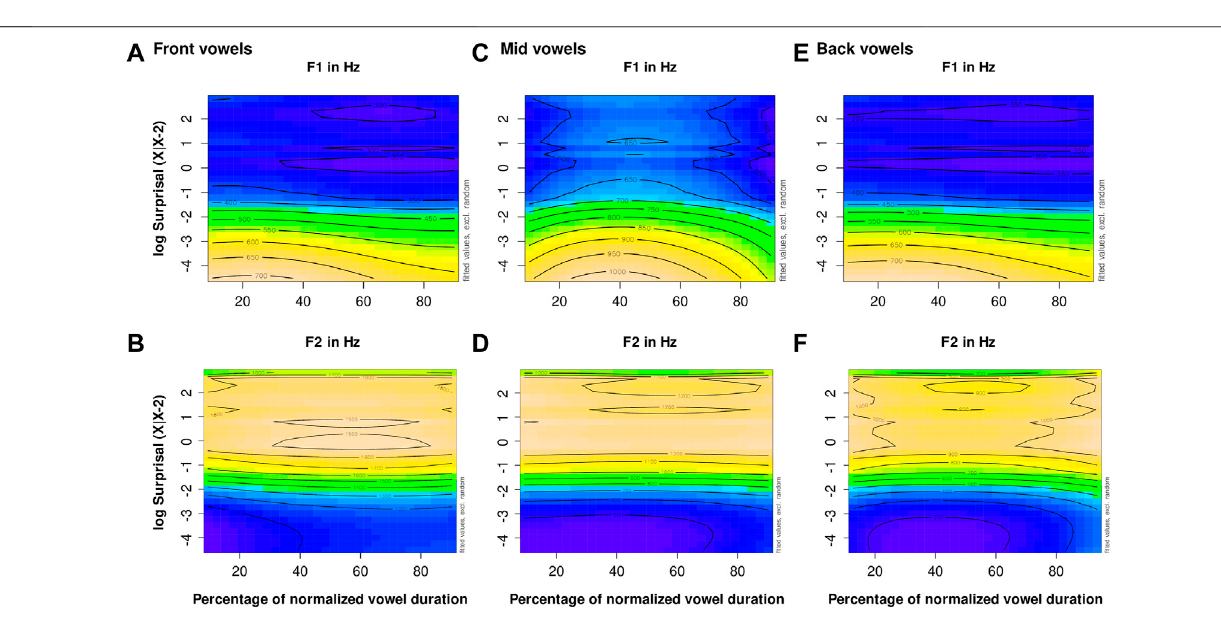
second formant trajectories of peripheral German vowels.